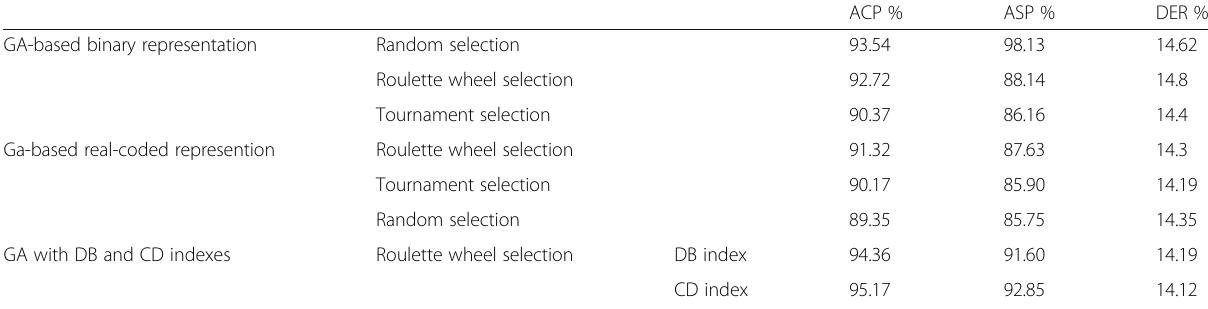
Table 5 DER results for GA algorithm obtained using DB and CD clustering validity indexes, with different selection, and the DER results obtained with “ sphere ” cost function for both GA-based binary representation and GA-based real-coded representation